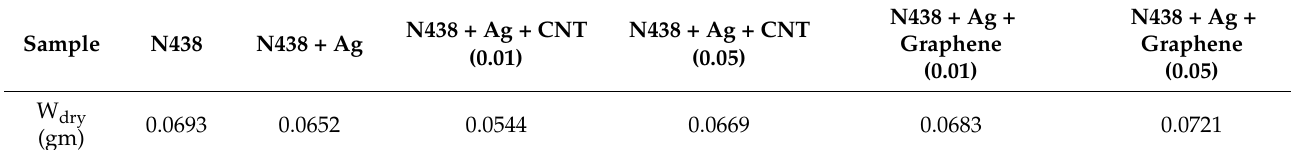
Figure 7. Traction Force at ( a ) 2N and ( b ) 3N. Table 3. Weight of the Samples before immersing in hot water.